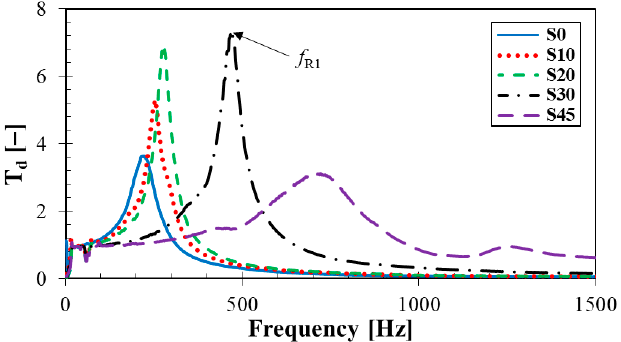
Figure 6. Effect of silica concentration on frequency dependencies of the displacement transmissibility of the tested rubber composites measuring t = 4 mm in thickness and loaded with inertial mass m = 90 g.